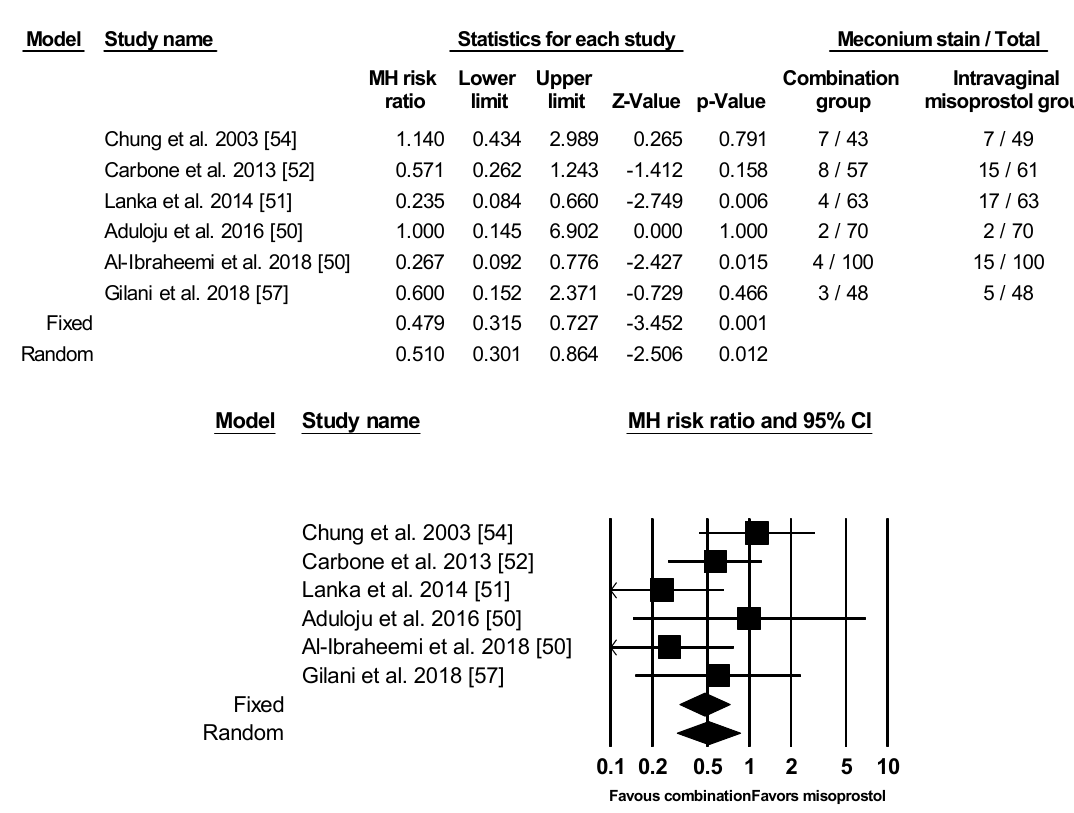
Figure 7. Comparison 6: Combination of intracervical Foley catheter and intravaginal misoprostol versus intravaginal misoprostol alone for cervical ripening, Outcome 6: Tachysystole with fetal heartbeat change. Heterogeneity: Tau 2 = 0.377; ꭓ 2 = 6.406 df = 2 ( p = 0.041); I 2 = 68.778%. Test for overall effect (random): Z= − 1.822 ( p = 0.068).